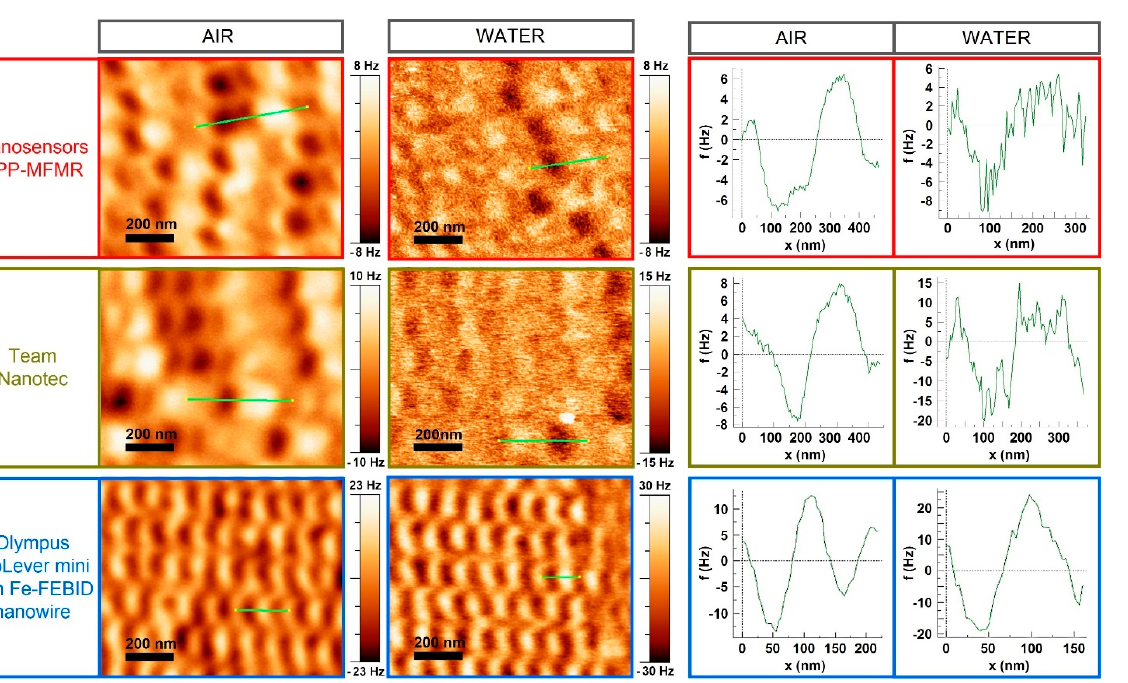
Figure 8. Comparison of the MFM images of a hard disk acquired in air and water environments for the commercial Nanosensors TM PP-MFMR and Team Nanotec tips, and for the functionalized Olympus BioLever mini with an Fe-FEBID nanowire. Adapted from [61] and reproduced from [41] with permission from the Royal Society of Chemistry.